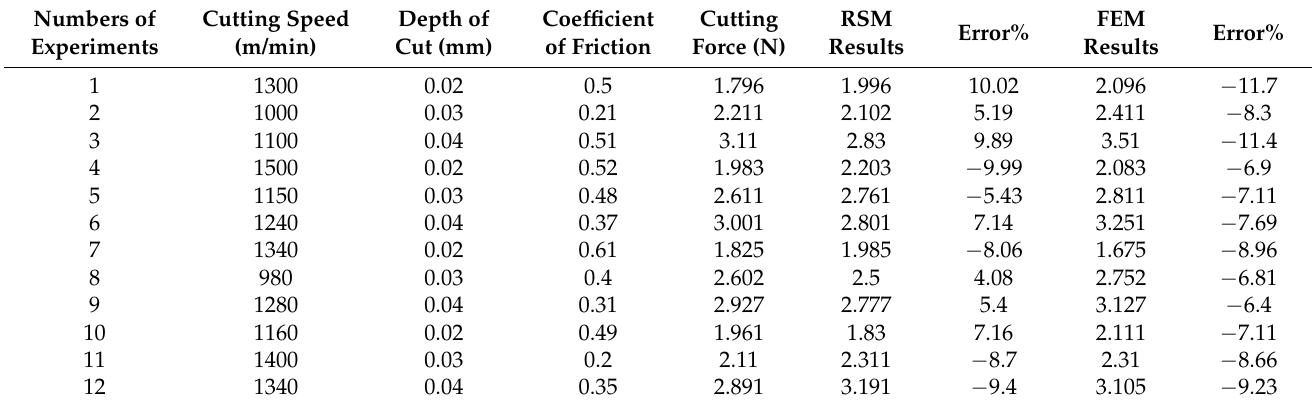
Table 5. Results of the confirmation